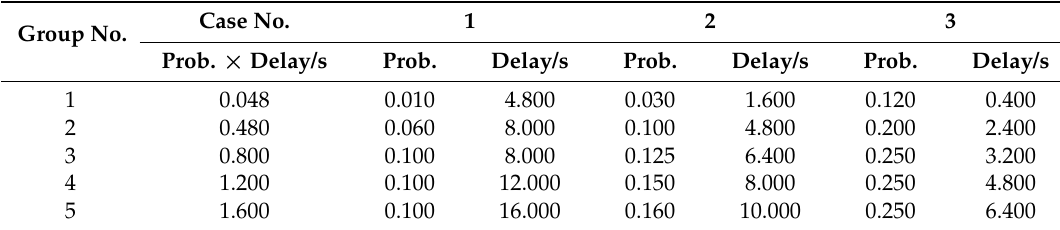
Table 1. Cases with various checking failure probabilities and delay times for the verification of equivalence.